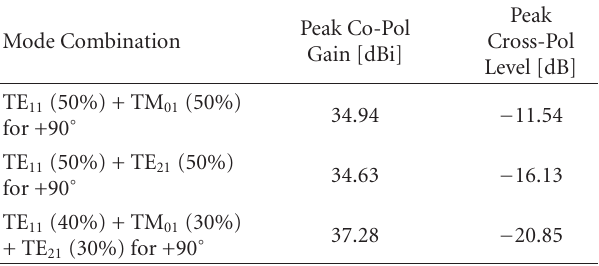
Table 3: Peak copolarization gain and peak cross-polarization level (below peak gain) values at 7.73GHz.